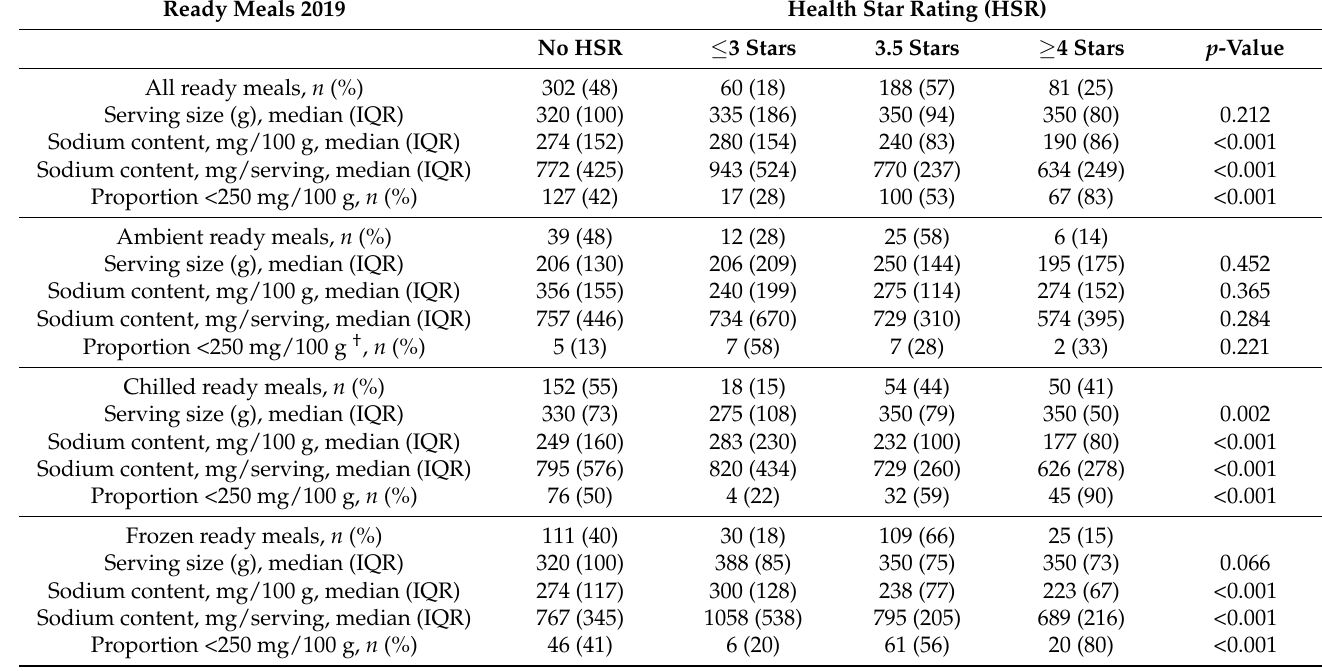
Table 2. Comparison of median (IQR) sodium content of products using the Health Star Rating on the front-of-pack and proportion meeting the Healthy Food Partnership sodium reduction target (<250 mg/100